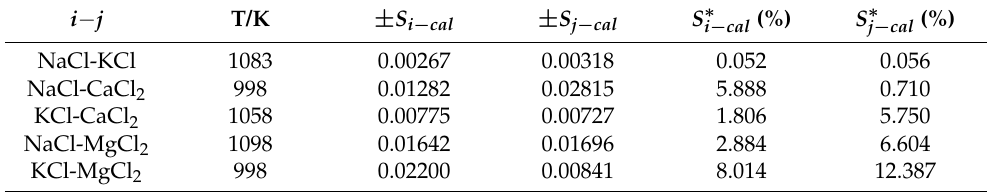
Table 6. Average relative deviation and standard deviation of the binary chloride systems.